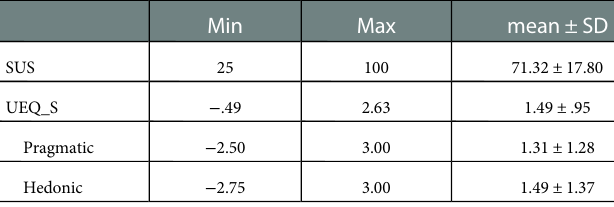
TABLE 2 Descriptive statistics ( n =46) on overall score on the system usability scale (SUS) and user-experience short questionnaire